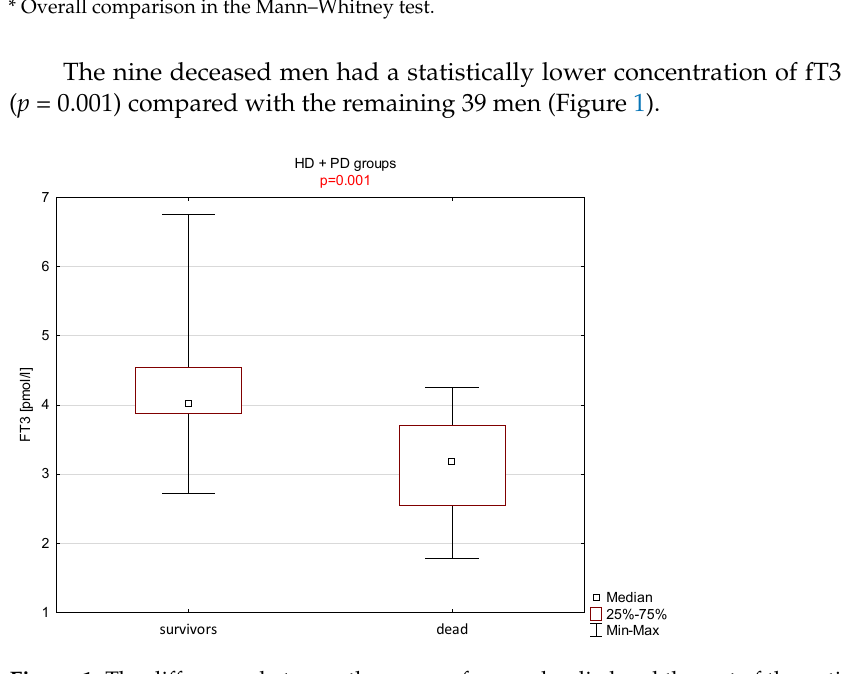
Figure 1. The differences between the group of men who died and the rest of the patients in terms of the serum fT3 concentrations.